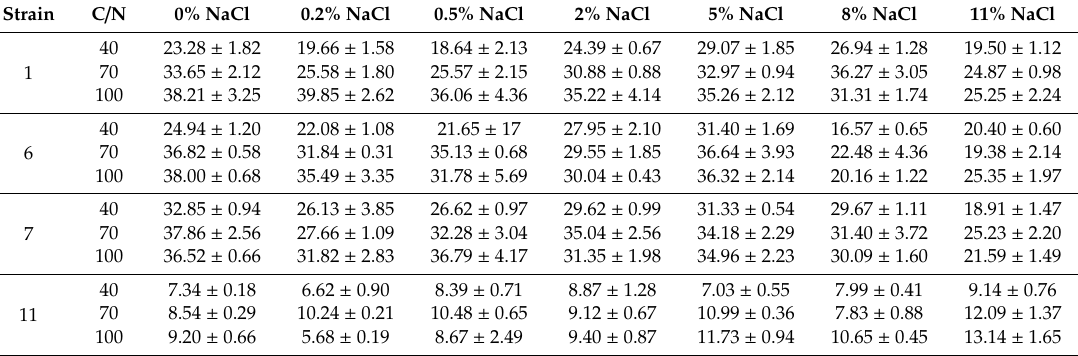
Table 7. The e ff ect of di ff erent osmolarity levels on the lipid production (% of DCW) in strains C. infirmominiatum CCY 17-18-4 (1), P. rhodozyma CCY 77-1-1 (6), R. kratochvilivae CCY 20-2-26 (7), S. cerevisiae CCY 21-4-102